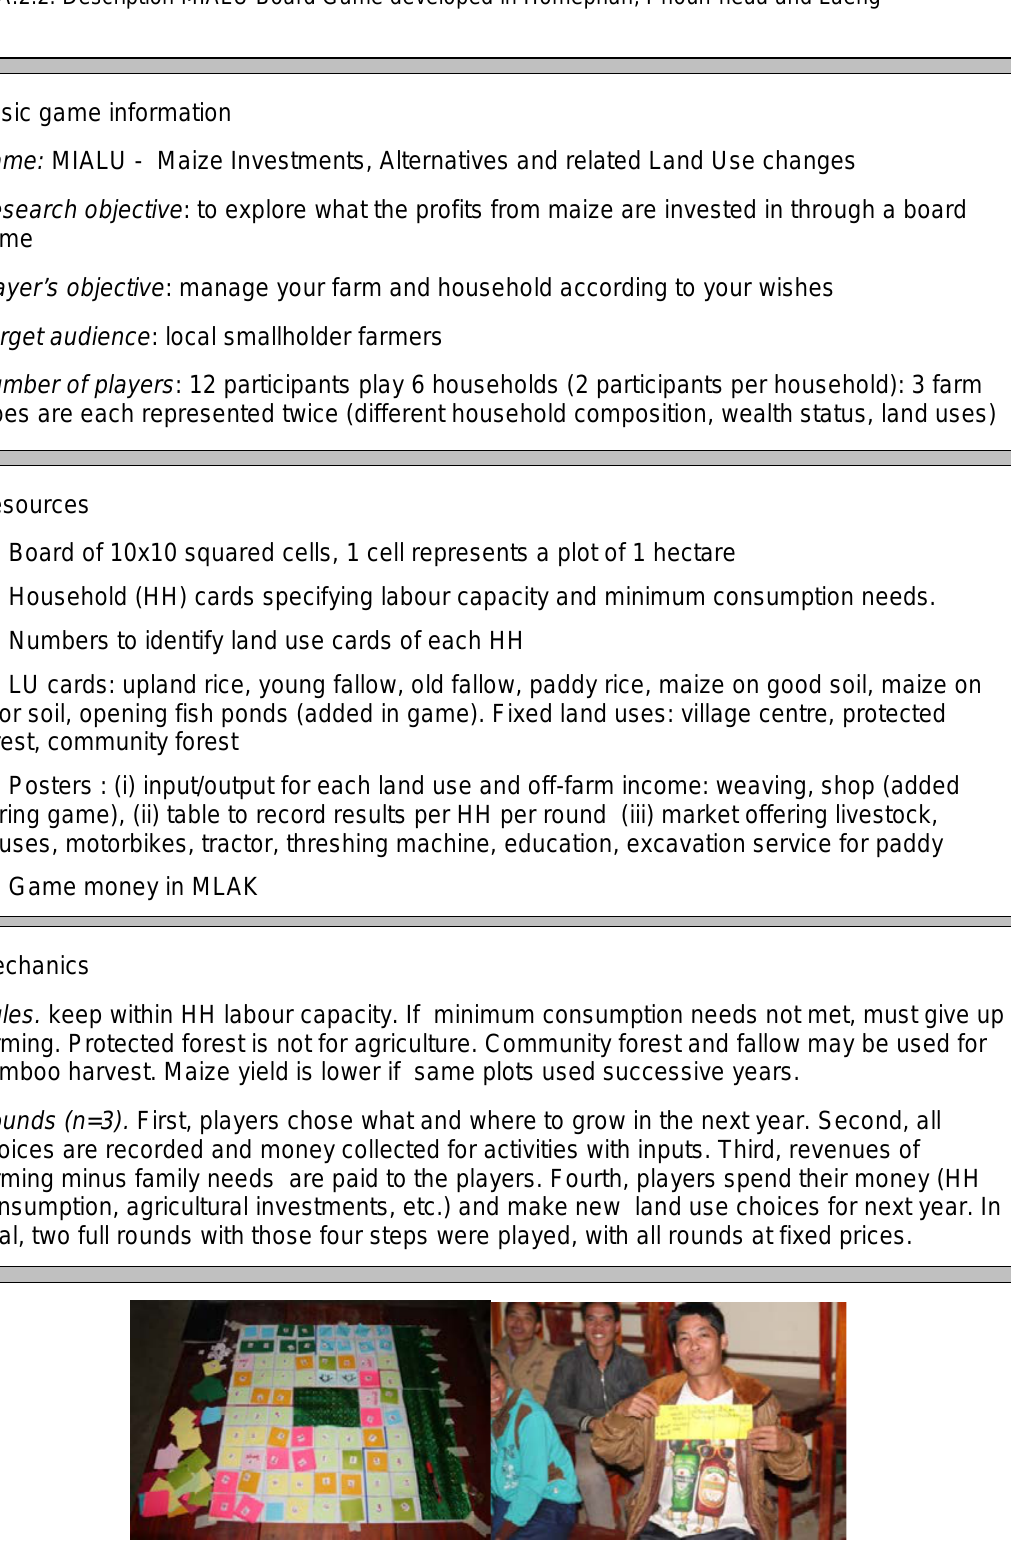
Figure A.2.2. Description MIALU Board Game developed in Homephan, Phoun-neua and